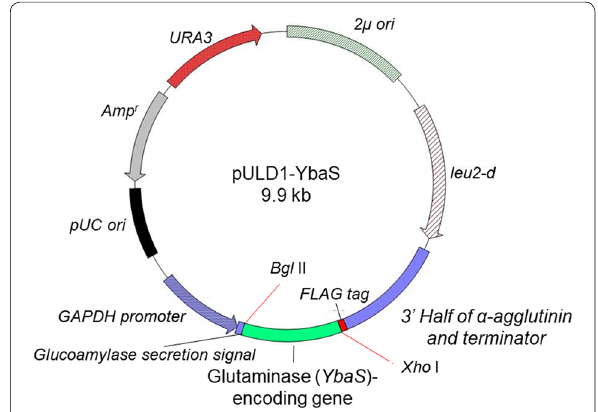
Fig. 1 The constructed plasmid for the cell surface display of glutaminase from E. coli (YbaS)